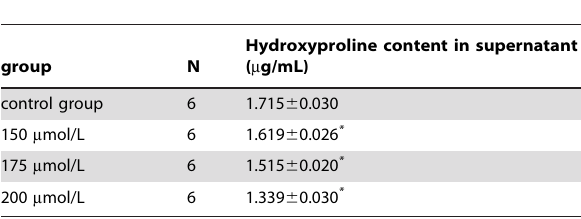
Table 2. Effects of Artesunate on secretion of hydroxyproline of HSCs ( x 6 s).